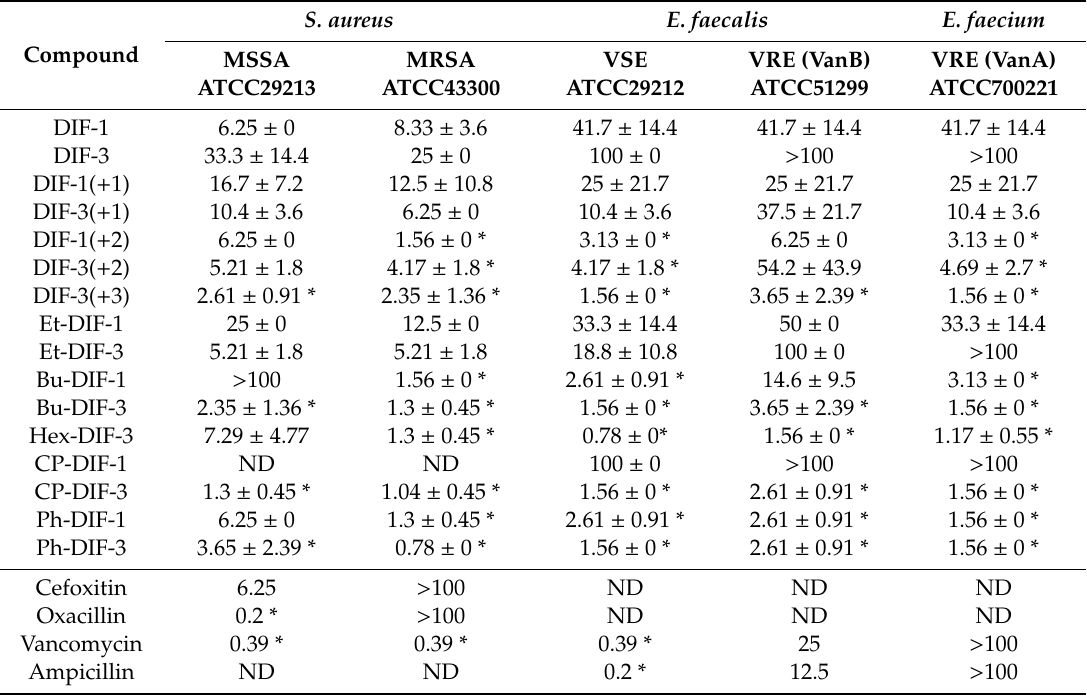
Table 2. MIC ( µ M) values of DIFs and derivatives against MSSA, MRSA, VSE, and VRE.